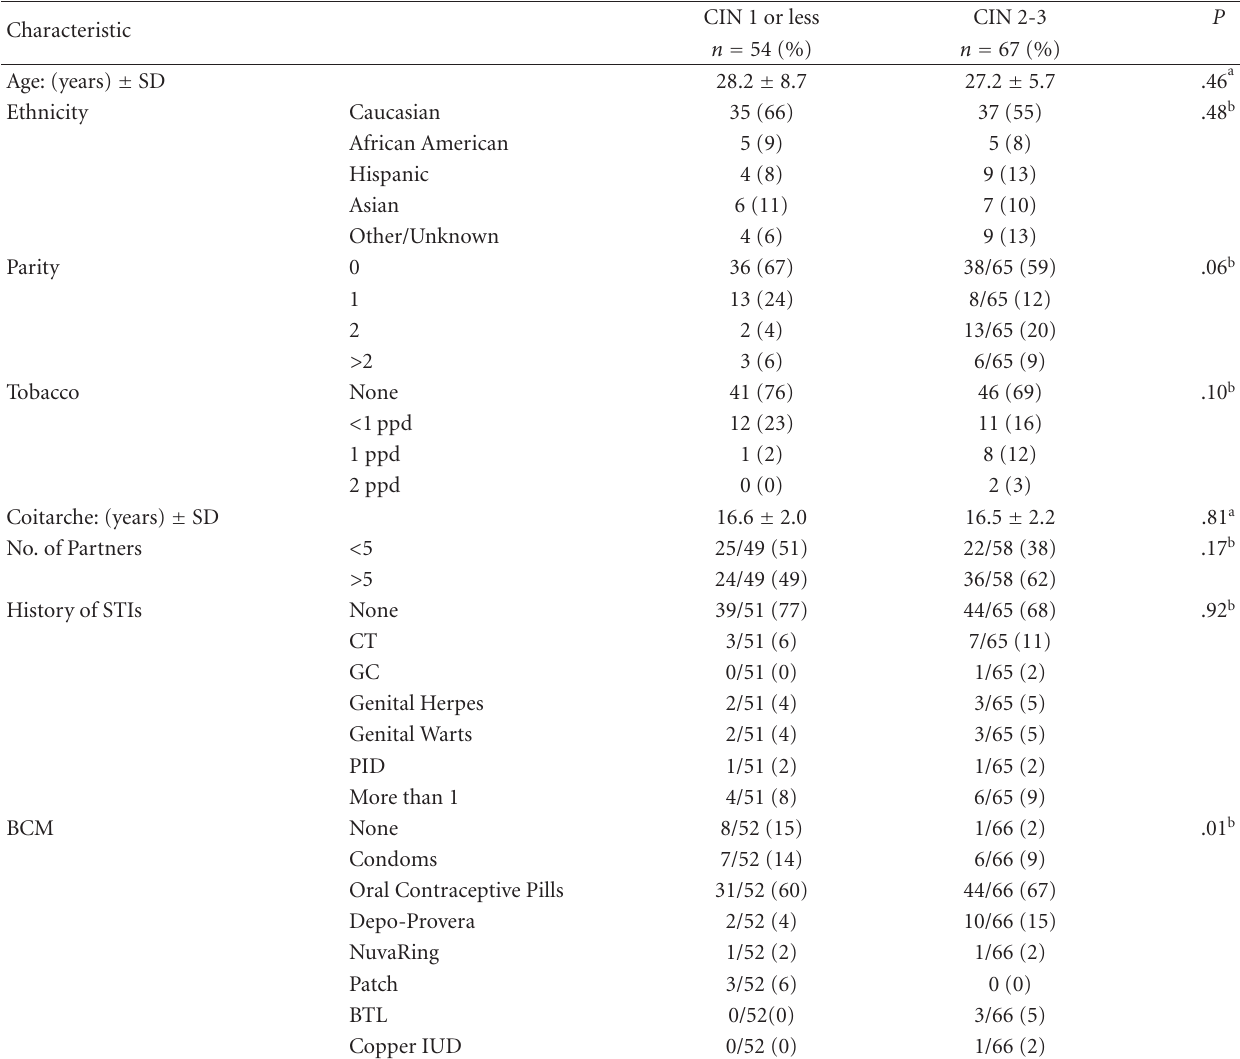
Table 1: Demographic characteristics comparing women with CIN 1 or CIN 2,3 on LEEP.